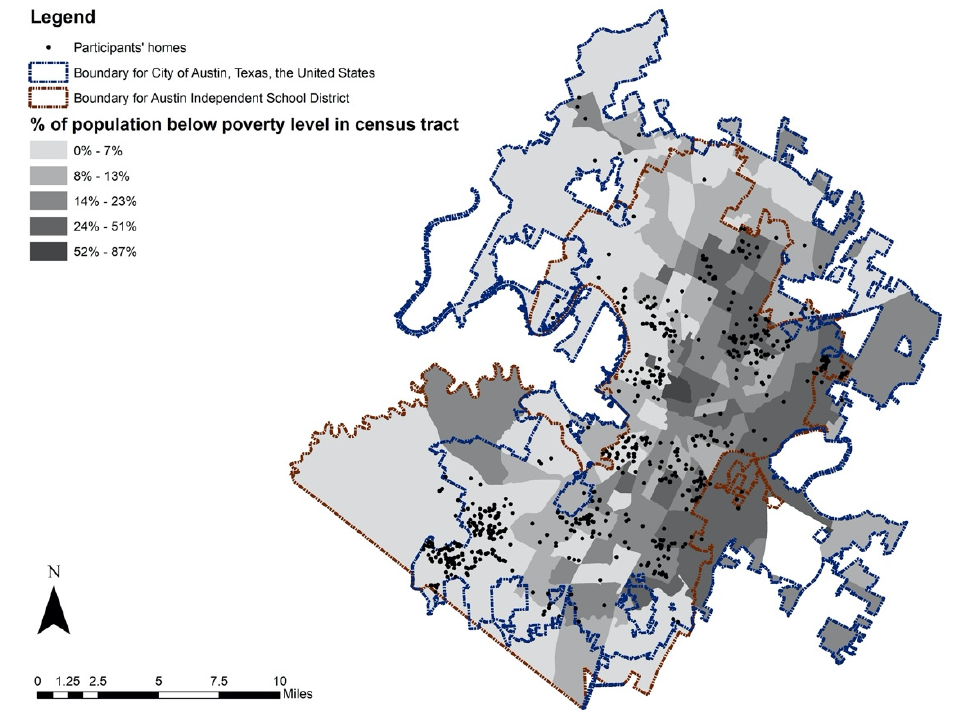
Figure 2. Study area and home locations of study participants.